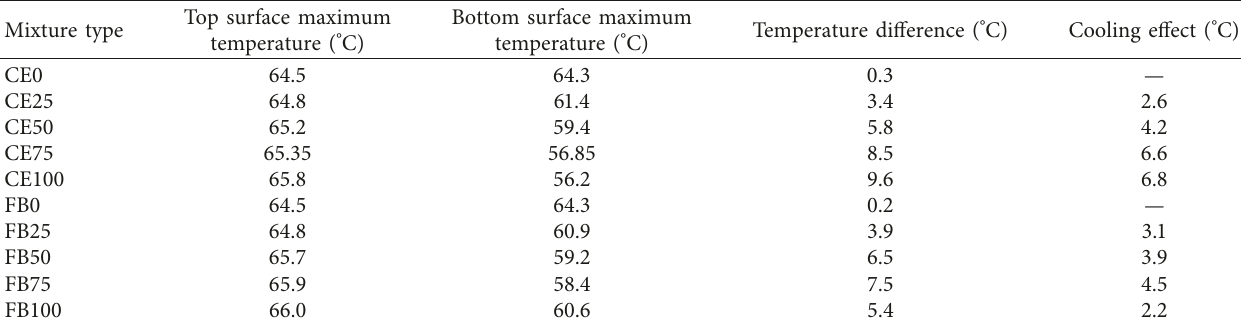
Figure 6: Temperature variation of the indoor illumination test ( ° C). (a) The top surface for CE type, (b) the bottom surface for CE type, (c) the top surface for FB type, and (d) the bottom surface for FB Table 6: Results of the indoor cooling effect for TRAM.